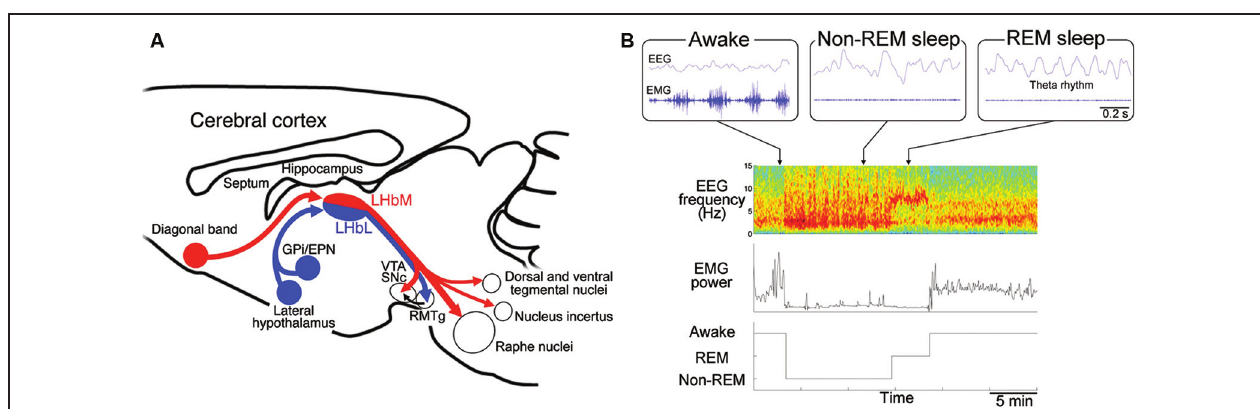
FIGURE 2 | Regulation of the rapid eye movement (REM) sleep by habenular projection. (A) Efferent targets of the LHb in regulation of REM sleep. Schematic diagram of a sagittal section of the mouse brain showing the afferent and efferent connectivity of LHbM (red) and LHbL (blue). LHbM receives inputs preferentially from the DB and send the axons to the serotonergic raphe nuclei, dorsal and ventral tegmental nuclei containing GABAergic neurons, nucleus incertus producing the neuropeptide relaxin-3 and dopaminergic ventral tegmental area (VTA) and substantia nigra, pars compacta (SNc). On the other hand, LHbL receives inputs preferentially from GPi/EPN and LH and sends the axons to the GABAergic rostromedial tegmental nucleus (RMTg). (B) Categorization of the sleep stage into